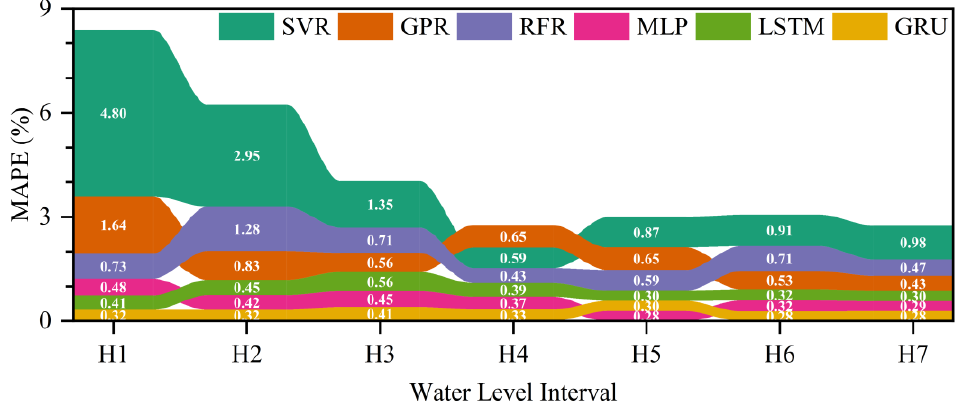
Figure 10. Ribbon diagram of the MAPEs for water level hydrograph prediction of Shashi Station by the models during the testing period.